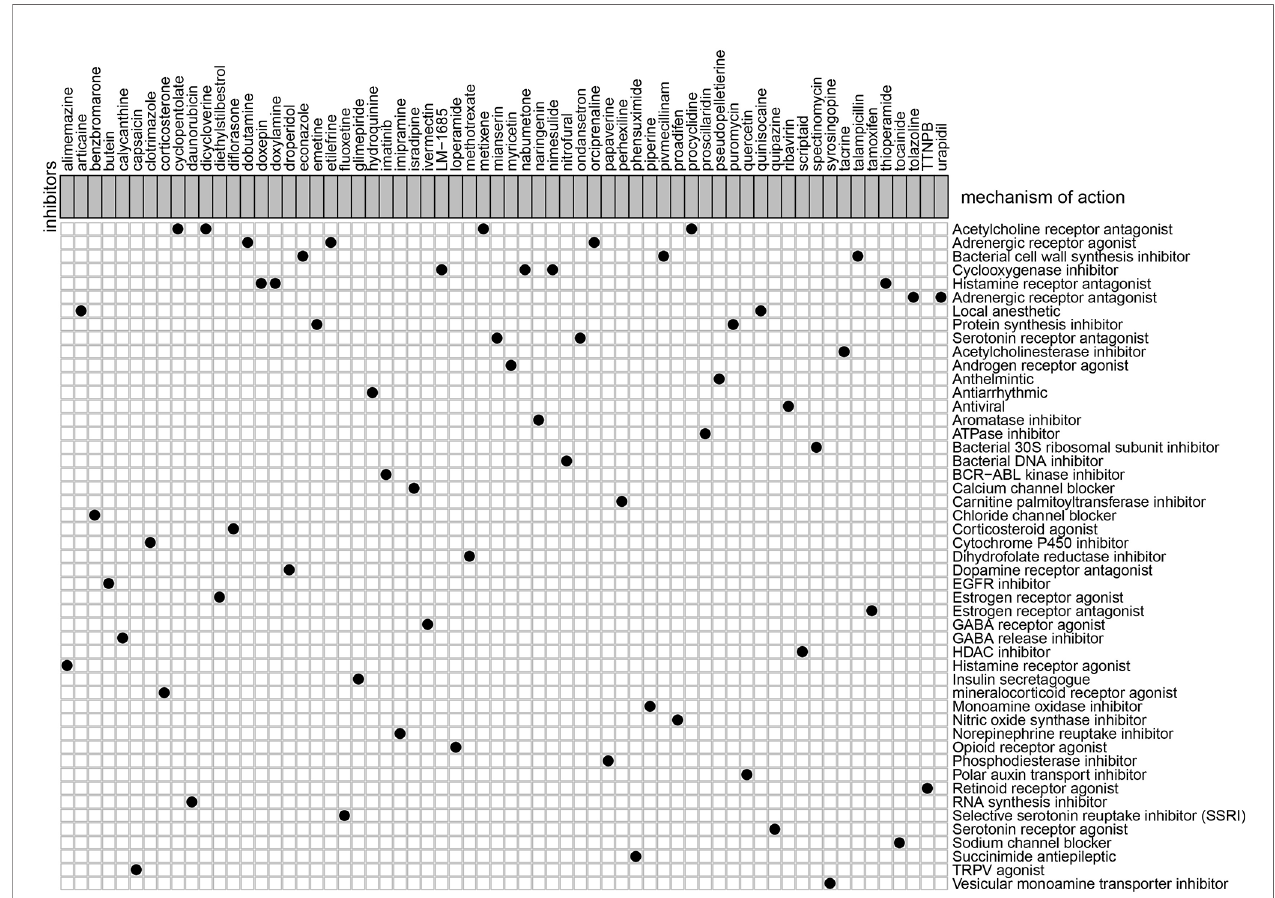
FIGURE 11 | Candidate drugs that were identi fi ed by the CMAP database were targeting the lncRNA-related